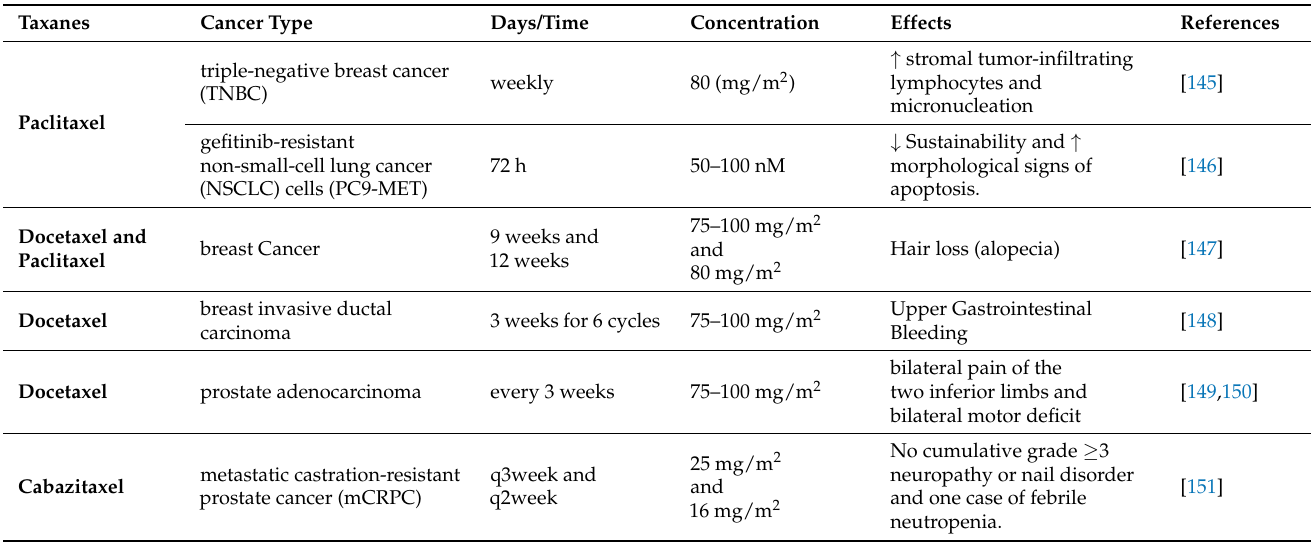
Table 2. Effects of taxanes with adequate concentrations. ↑ represents upregulation ↓ represents